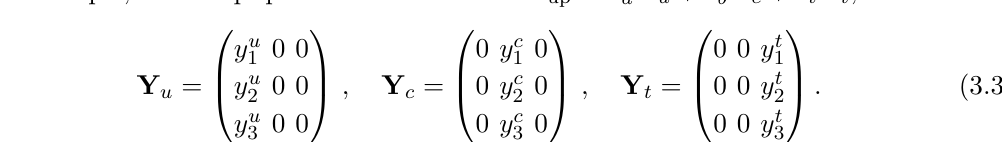
1. For example, in the up-quark sector we have M